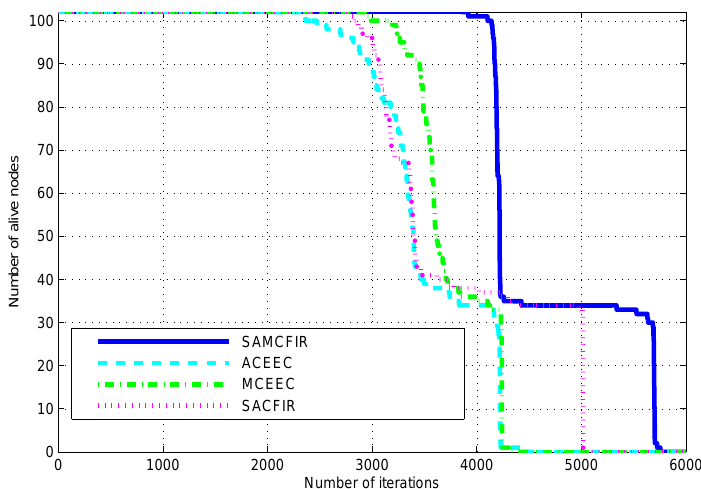
Figure 8. Energy Efficiency in terms of network lifetime in network of 100 m × 100 m with 100